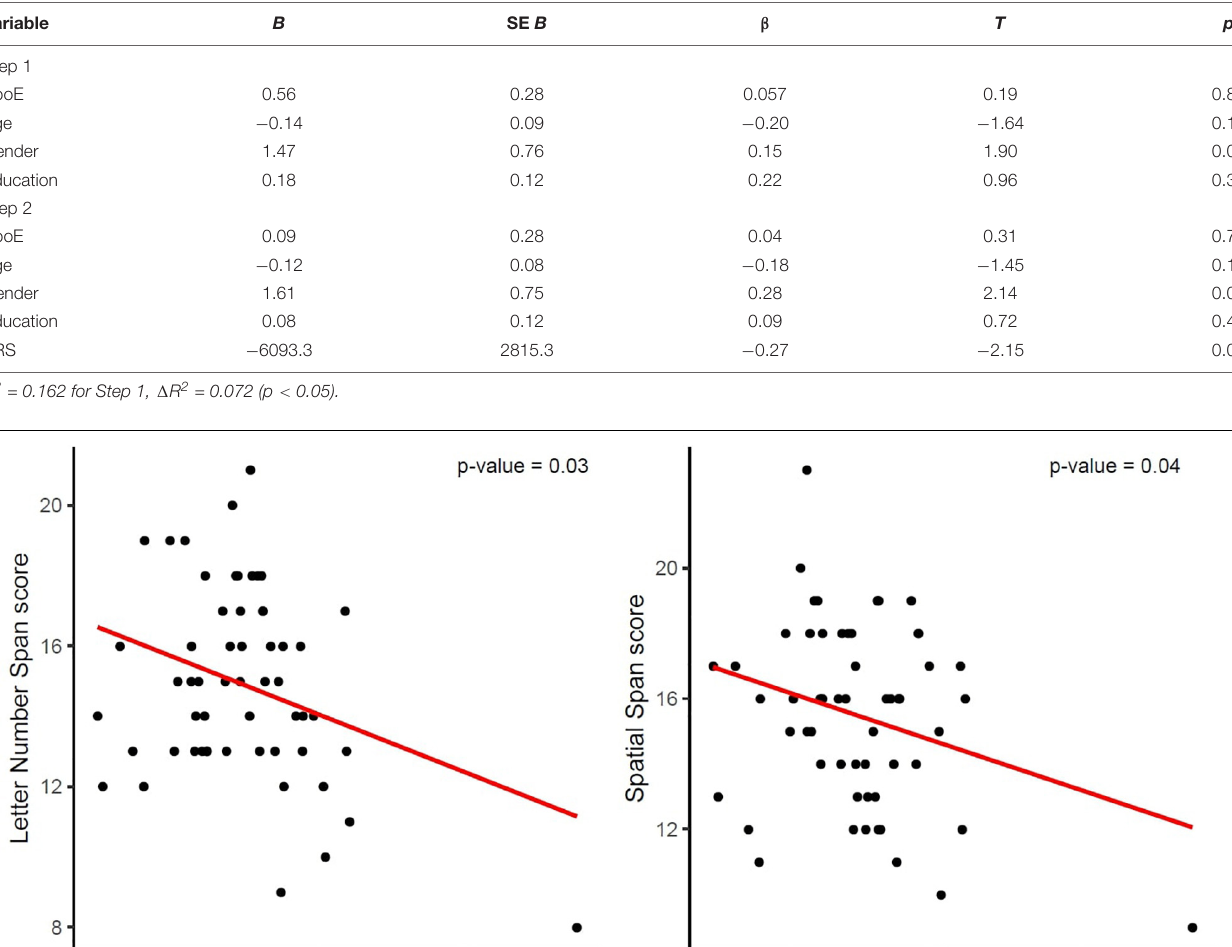
TABLE 3 | Summary of hierarchical regression analysis for variables predicting Spatial Span performance.